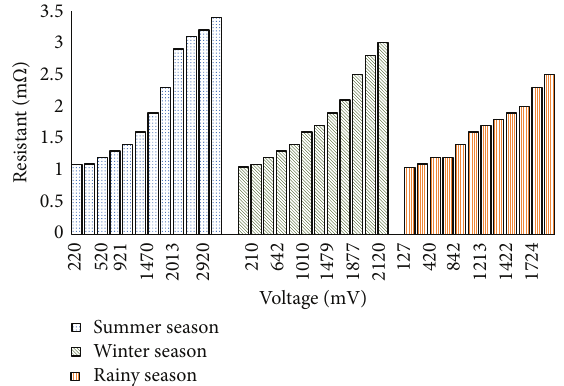
Figure 12: Comparison of voltage versus resistance in the duration of 11.00 am to 1.00 pm in summer, winter, and rainy